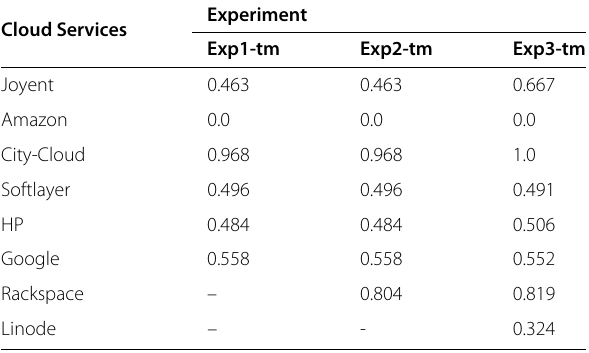
Table 16 Total Measure for Each